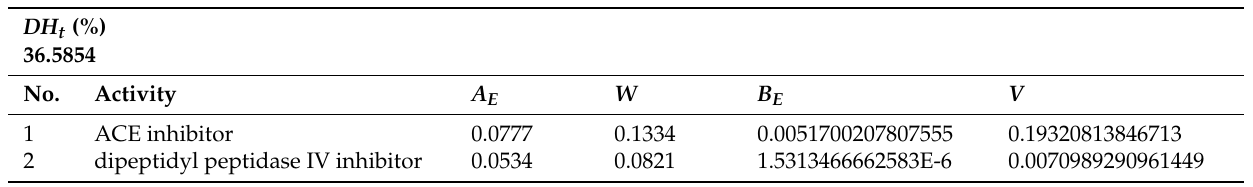
Table A16. A E , DH t , W , B E and V values from RubisCO of Halophila stipulacea . In silico enzymatic cleavage was carried out by thermolysin.